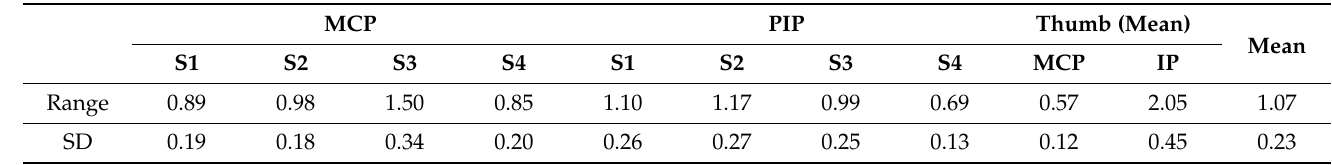
Table 2. Repeatability results for test A. Angular readings were generated using NN lookup tables for each data glove